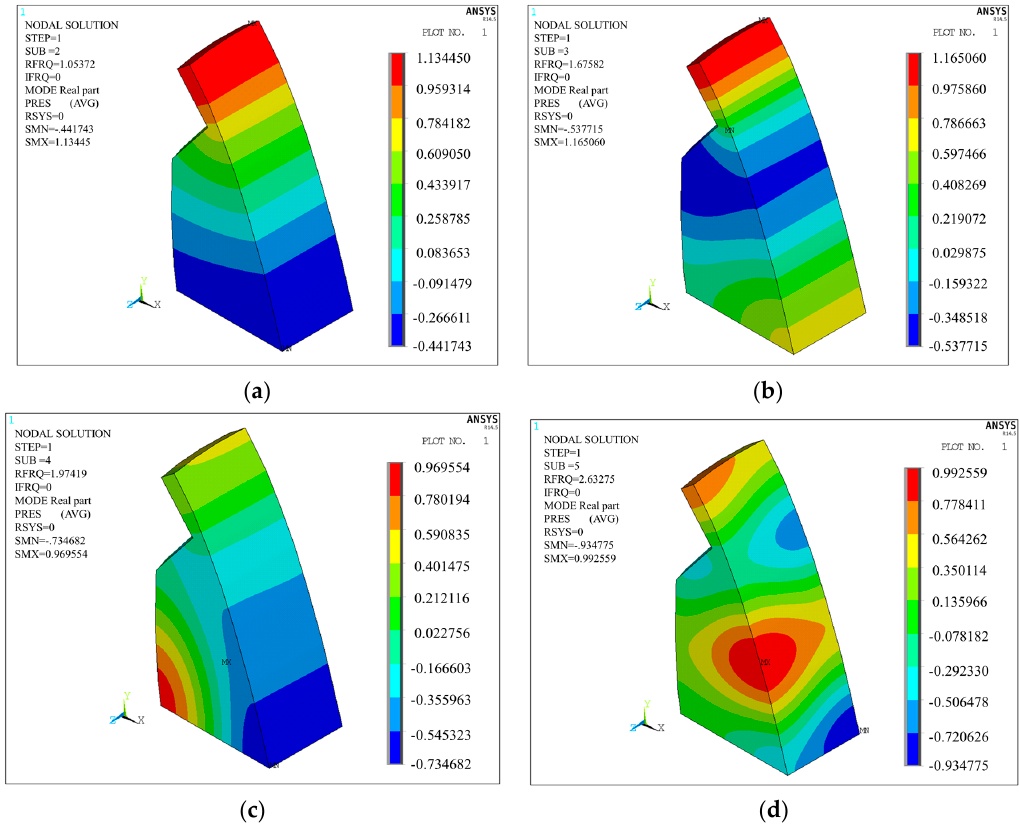
Figure 17. Cavity acoustic modal vibration mode of Condition 6: ( a ) Second order; ( b ) Third order; ( c ) Fourth order; ( d ) Fifth order.